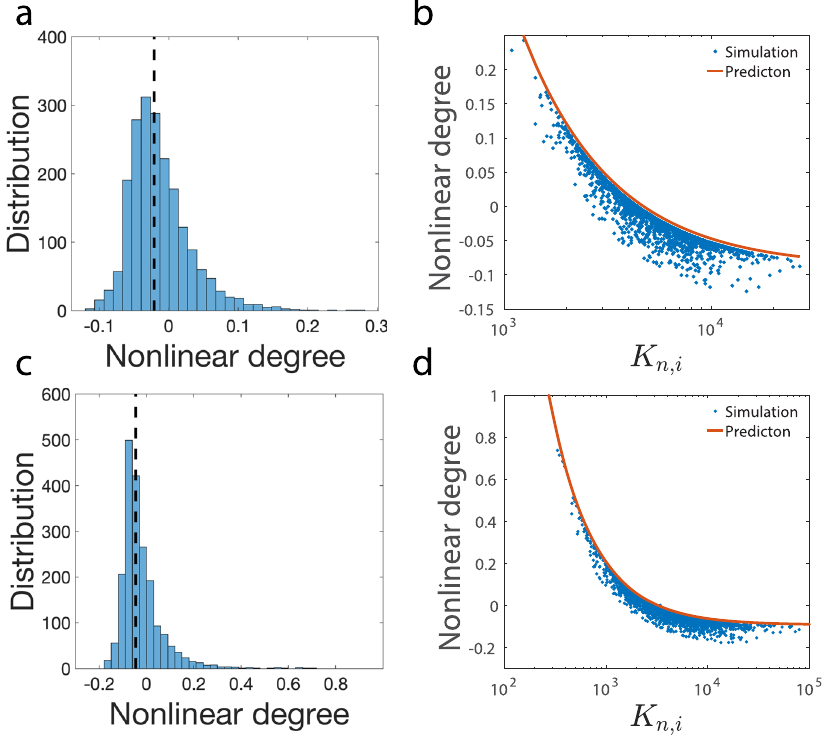
Fig. 3 Simulation of the scenario in which K n , i is continuously distributed. a Distribution of the measured nonlinear degrees β of mRNA numbers from numerical simulations. The dashed line marks the location of the median value of the nonlinear degrees. b We compare the theoretically predicted nonlinear degrees of mRNA numbers and the measured one from numerical simulations. In ( a ) and ( b ), the coef fi cient of variation of K n , i is 0.5. c, d The same analysis as ( a, b ) with the coef fi cient of variation of K n , i equal to